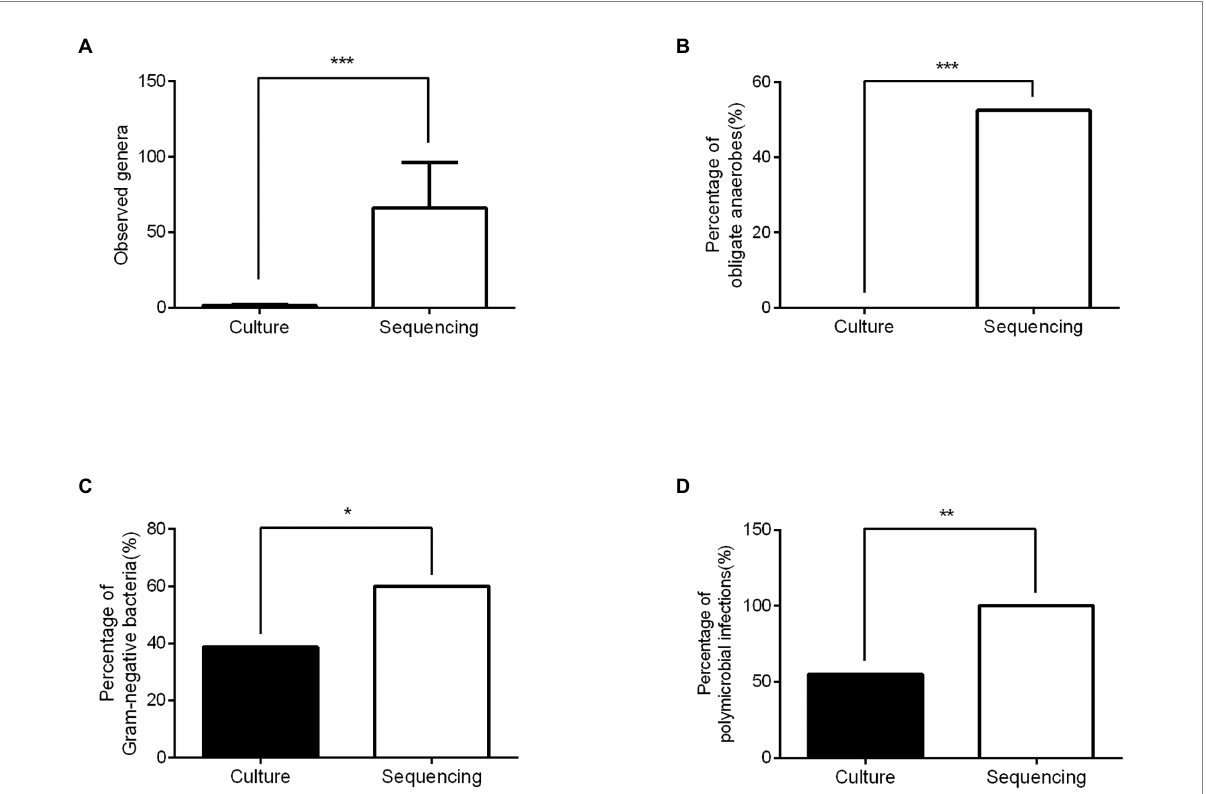
FIGURE 2 Comparison of the microbiological diagnosis between conventional culture and 16SrRNA sequencing. (A) The numbers of genera identified in the sequencing group were significantly higher than those in the culture group. (B) Significantly more obligate anaerobes were detected in the sequencing group than in the culture group. (C) The percentage of Gram-negative bacteria in the sequencing group was higher than that in the culture group. (D) More polymicrobial infections were detected in the sequencing group than in the culture group. *** p < 0.001, ** p < 0.01, and * p <